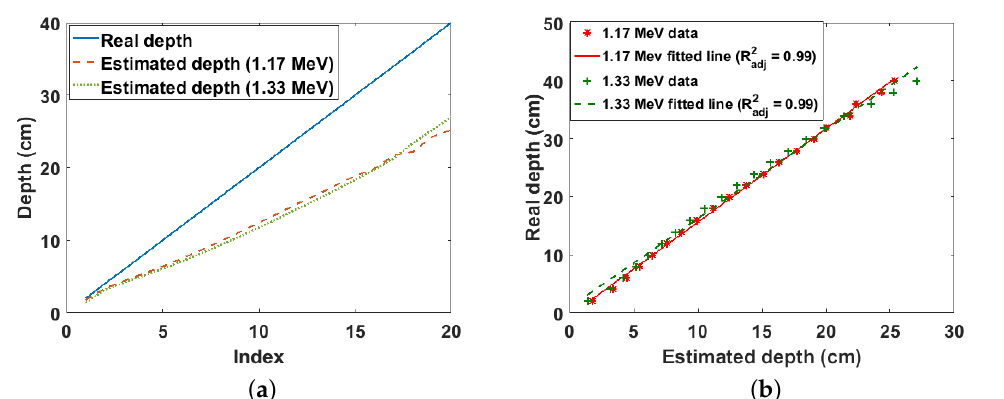
Figure 9. ( a ) Eeal and estimated depths for Co-60 buried in sand. Index is the position of each depth value in the depth array; ( b ) linear fit of real and estimated depth for Co-60 buried in sand.